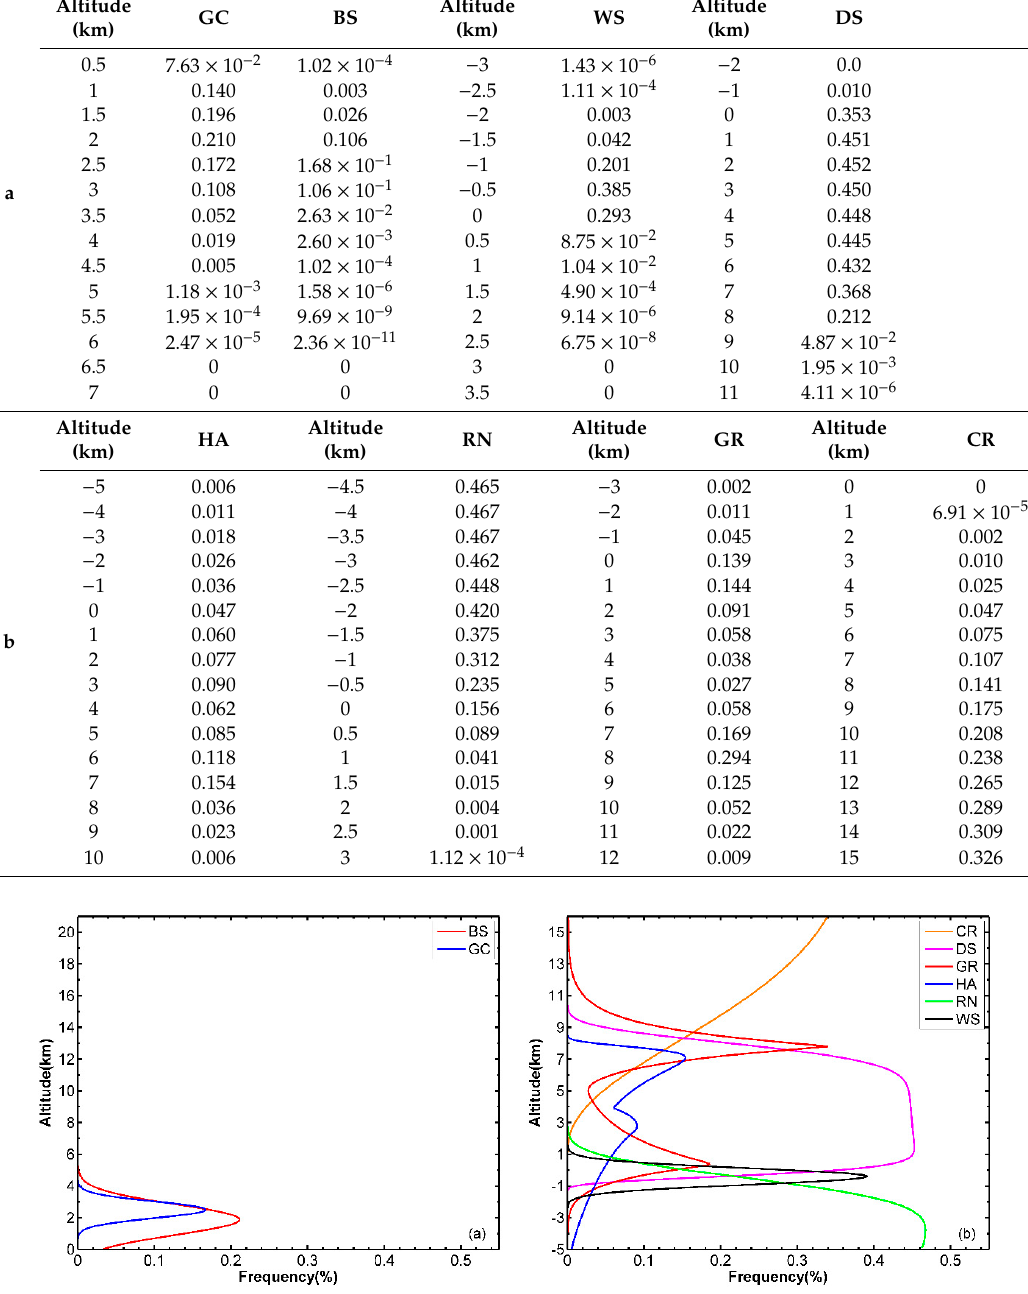
Figure 2. Prior PDFs. Altitude in ( a ) is relative to the mean sea level, whereas altitude in ( b ) is relative to the freezing level.